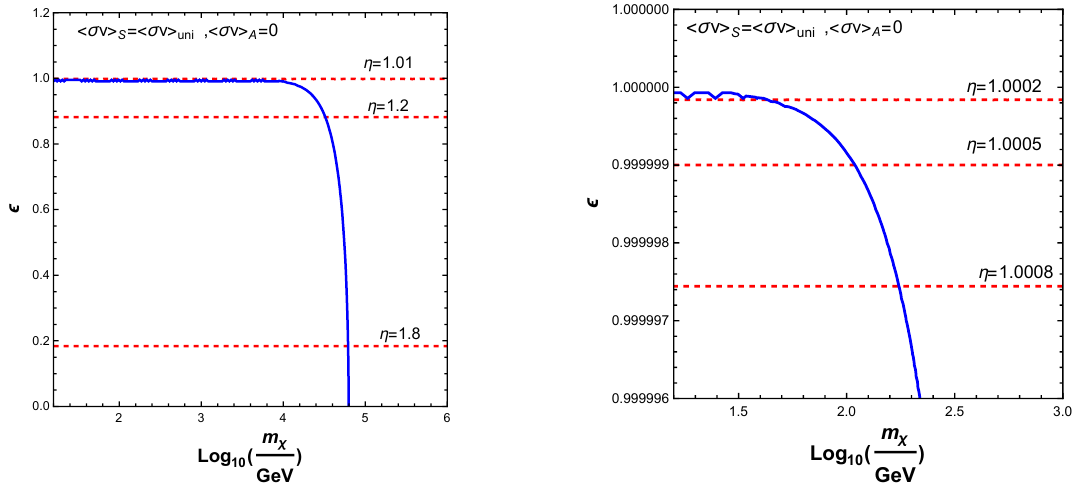
Figure 4 . Contours in the m (cid:31) (cid:15) plane in which the central value of the DM relic density (cid:10) h 2 = 0 : 12 (cid:0) is reproduced, with the semi-annihilation rate (cid:12)xed at its s-wave upper bound implied by S-matrix (cid:27)v (cid:27)v unitarity, = = (4 (cid:25)=m 2 )( x F =(cid:25) ) 1 = 2 . The (cid:17) parameter is the same as de(cid:12)ned for (cid:12)gure 3, (cid:31) h i S h i uni with (cid:17) 1 being completely asymmetric DM. The right panel is the zoomed in version of the left ! panel focussing on a narrower region in the CP-violation parameter (cid:15) . See text for further details. in this (cid:12)gure is asymptotic, where the small numerical di(cid:11)erences are not clear from the plot shown (which, however, we have checked numerically). For (cid:15)